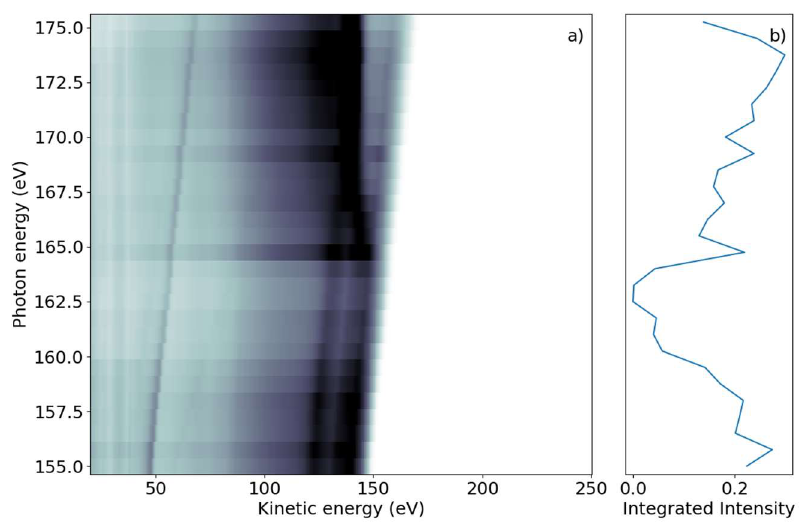
Figure 1. ( a ) Photon energy vs. electron kinetic energy for the 2-tUra sulfur 2p edge. The valence emission can be discerned as dispersing diagonal lines. Resonant and non-resonant Auger–Meitner emission splits off from the valence signal when the photon energy reaches the 2p binding energy. ( b ) NEXAFS spectrum obtained by integrating the electron emission intensity over the whole kinetic energy range. The 2p edge marks an increase in emitted signal, with some spectral features visible as peaks in the NEXAFS.